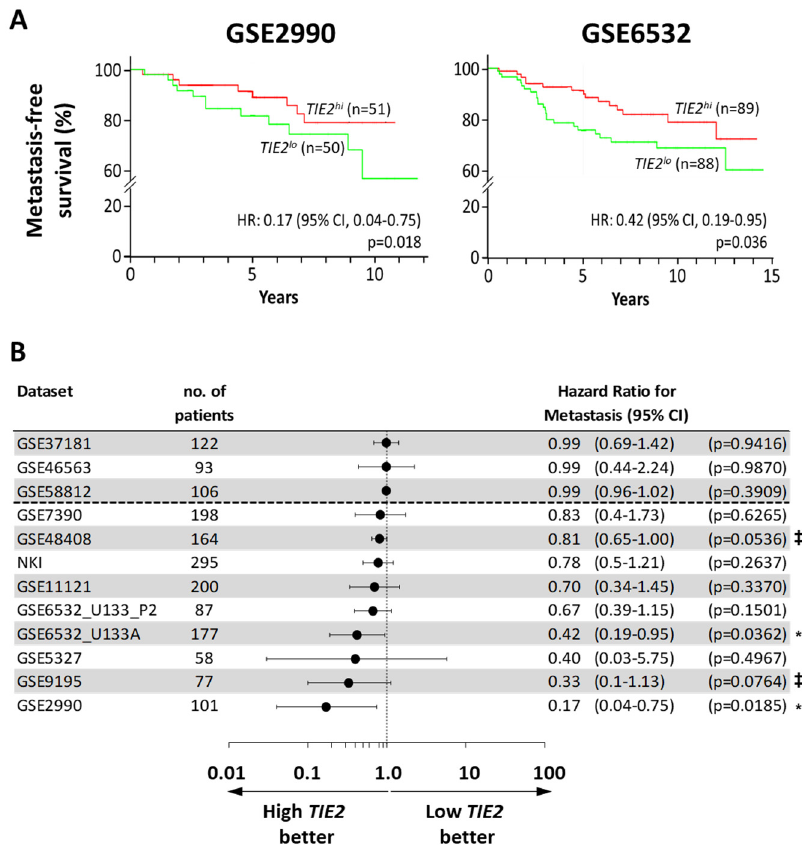
Figure 1. High TIE2 expression in the primary tumor is associated with an increased time to the detection of metastases in breast cancer patients. Analysis of metastasis-free survival using the PROGgene database. The median TIE2 mRNA level in the primary tumor was taken as a bifurcation point. Results are presented as ( A ) Kaplan–Meier plots for the Sotiriou (GSE2990) and Loi datasets (GSE6532), or as ( B ) a forest plot, indicating the overall hazard ratio (HR) for metastasis-occurrence and 95% confidence interval (CI). Survival analysis was performed using a log-rank test, ‡ p < 0.078, and * p < 0.05.